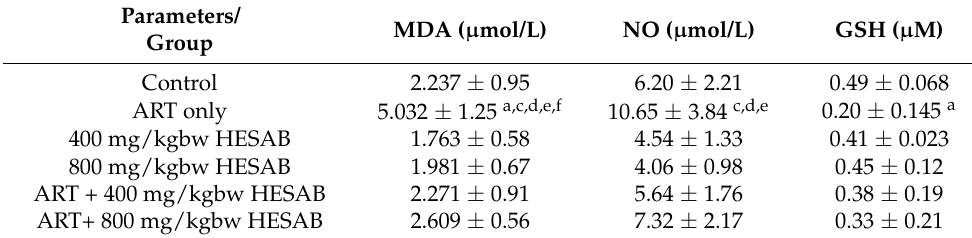
Table 4. Effect of HESAB on oxidative stress